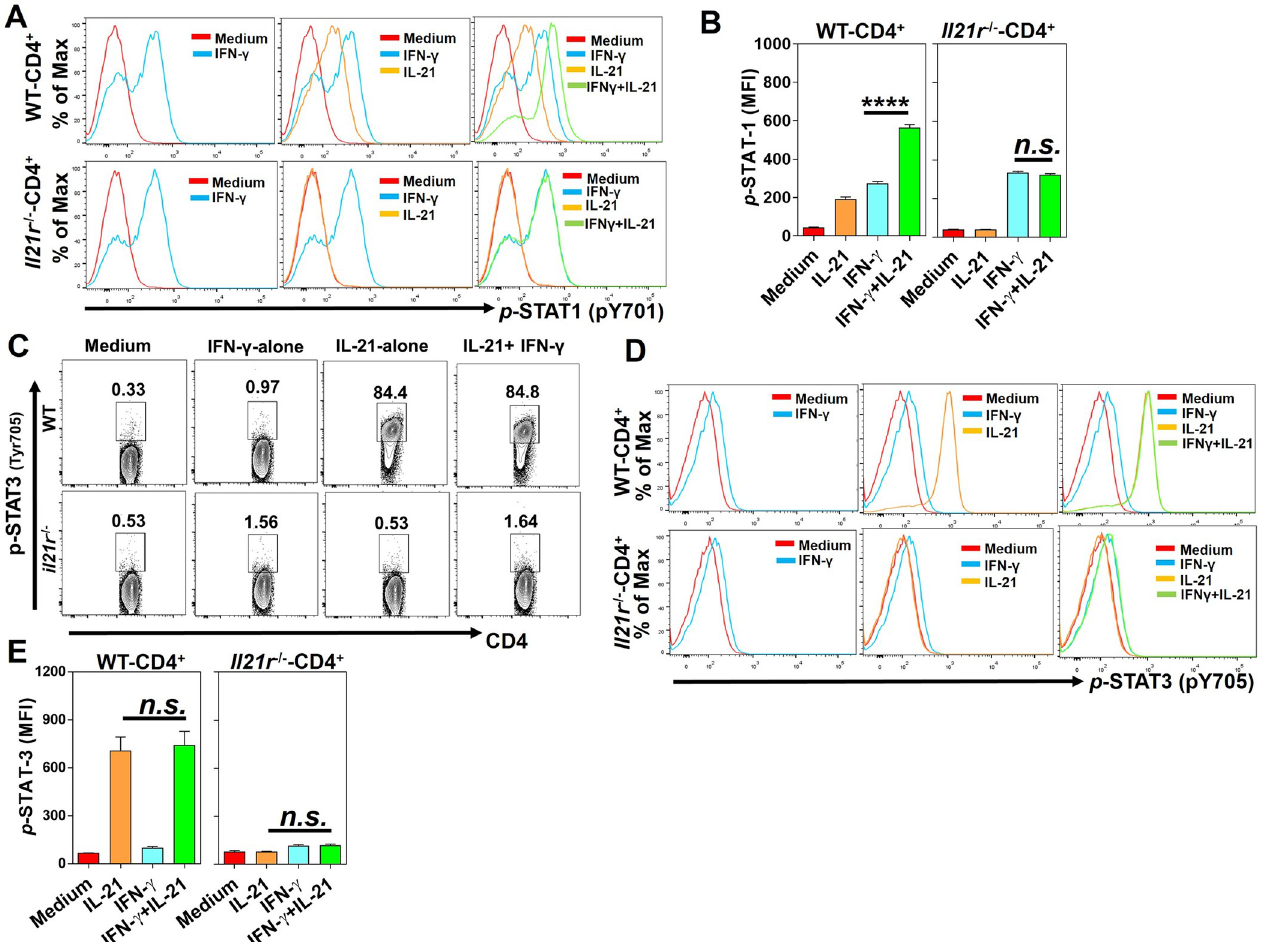
Fig 5. IL-21 is required for optimal activation of STAT1 in CD4 + T cells. A . Flow cytometric analysis of phosphorylated ( p -) STAT1 ( p Y701) in CD4 + T cells isolated from WT (top row) and Il21r -/- (bottom row) mice in the presence of mIFN- γ (20 ng/ml) or mIL-21 (20 ng/ml) alone or in combination (20 ng/ml of each cytokine) for 10 min. Cells receiving no cytokine treatments were used as controls (red histograms). B . Bar graphs showing the average mean fluorescent intensity (MFI) increase in p -STAT1 in WT (left panel) and Il21r -/- mice (right panel). C-E. Flow cytometry analyzing phosphorylated ( p -) STAT3 ( p Y705) in CD4 + T cells isolated from WT (top row) and Il21r -/- (bottom row) mice in the presence of mIFN- γ (20 ng/ml) or mIL-21 (20 ng/ml) alone or in combination (20 ng/ml of each cytokine) for 30 min. Cells receiving no cytokine treatments were used as controls (red histograms). Bar graphs showing the average mean fluorescent intensity (MFI) increase in p -STAT3 in CD4 + T cells isolated from WT (left panel) and Il21r -/- mice (right panel). The results are the Mean ± SEM of one experiment ( n = 3/genotype/condition) from two independent experiments. n . s , not significant; One-way ANOVA followed by Bonferroni post-hoc adjustment test for multiple